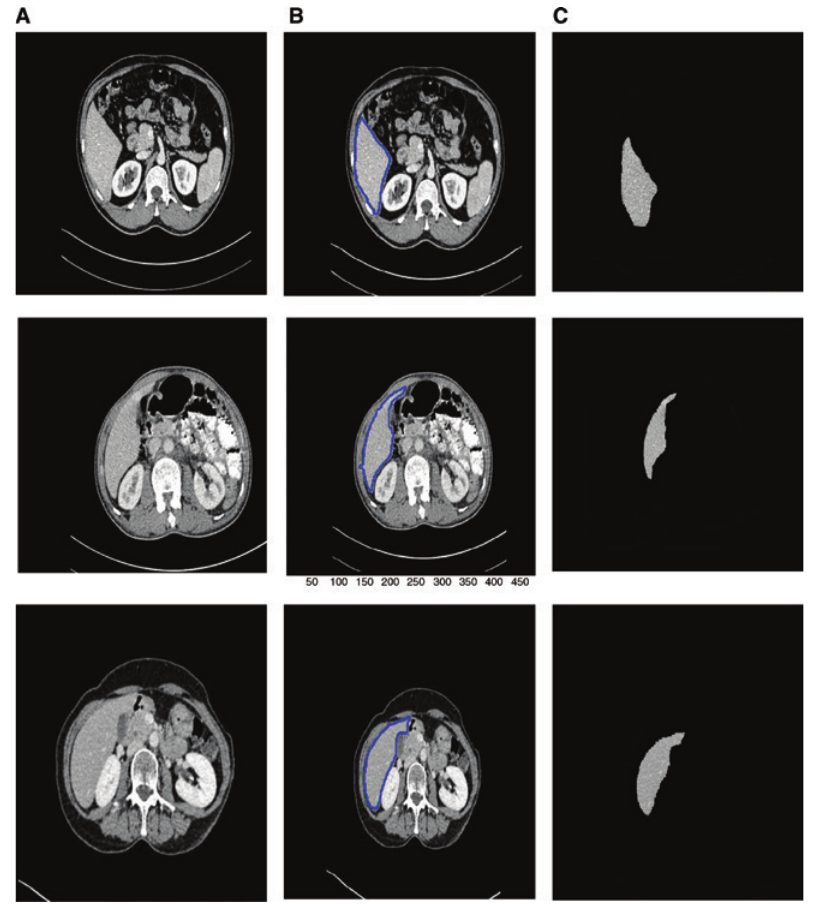
Figure 4: Experimental Results of Proposed Method for CT Scan Images. (A) Original CT scan image; (B) CT scan with liver boundary; (C) ground truth